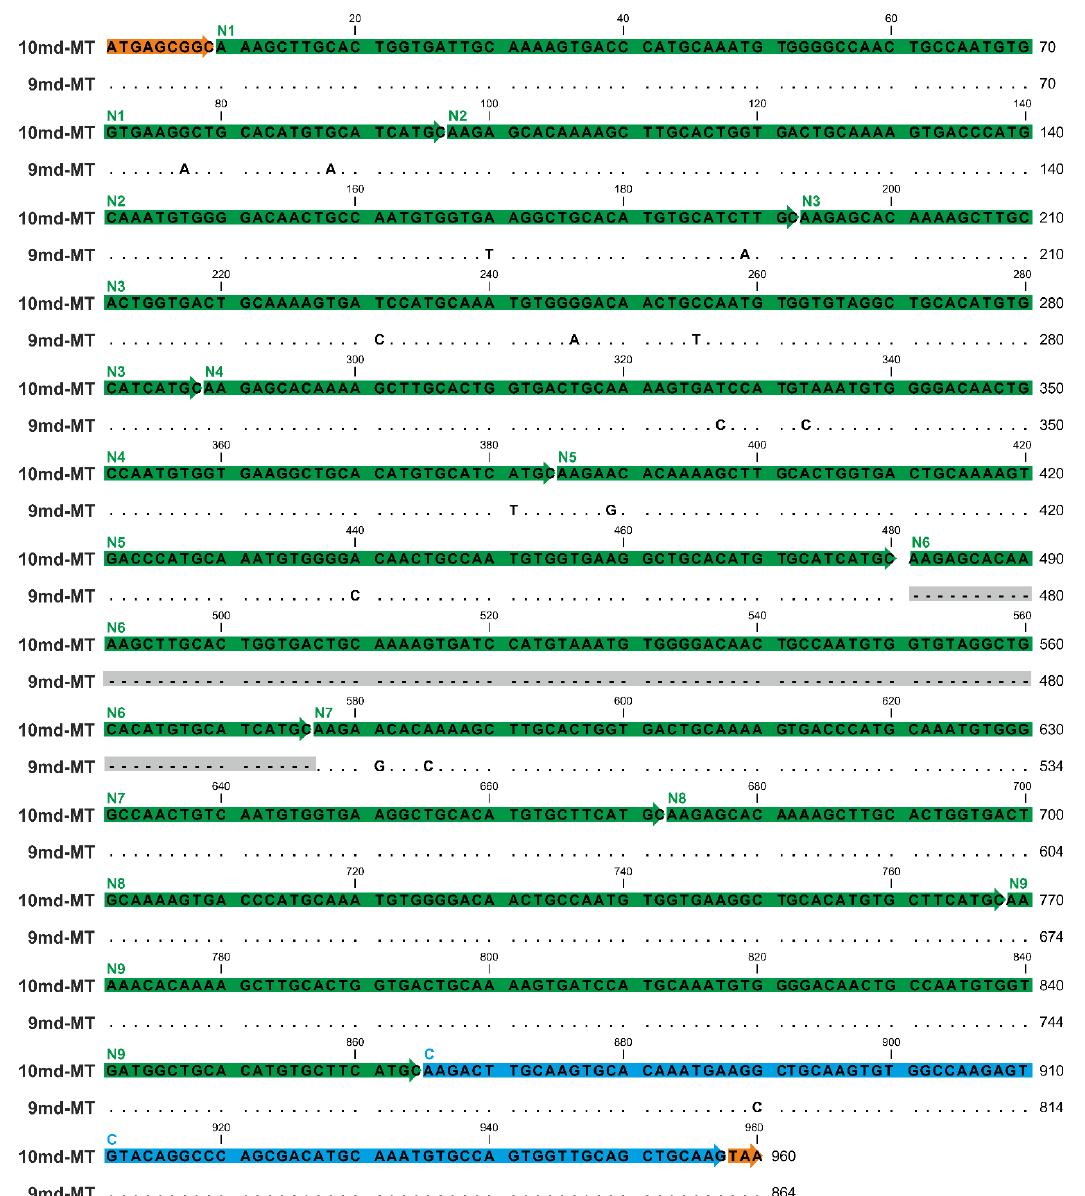
Figure 4. Gene / RNA sequence alignment of the two md-MT isoform genes ( 10md-MT and 9md-MT ) of A. biplicata . The gene sequences correspond to the detected RNA sequences because introns are lacking in the two 9md and 10md - MT genes. The orange boxes indicate the respective start sequences and the stop codon. The N-terminal repetition domains (N1–N9) are highlighted through green arrows, whereas the C-terminal domain is marked in blue. Dots represent identical nucleotides present in both md-MT genes; base replacements between the two genes are indicated by respective letters. The missing sequence of the N6 domain within the 9md-MT gene is shadowed in grey.